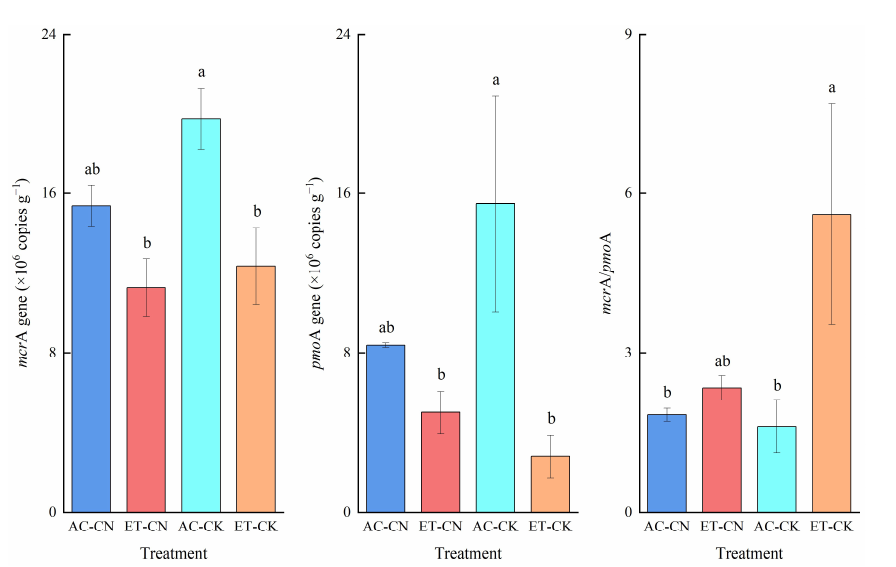
Figure 3. The copies of mcr A, pmo A genes and mcr A/ pmo A ratio as affected by temperature and fertilization. Different letter on the bars means the significant difference with confidence level set at 0.05.